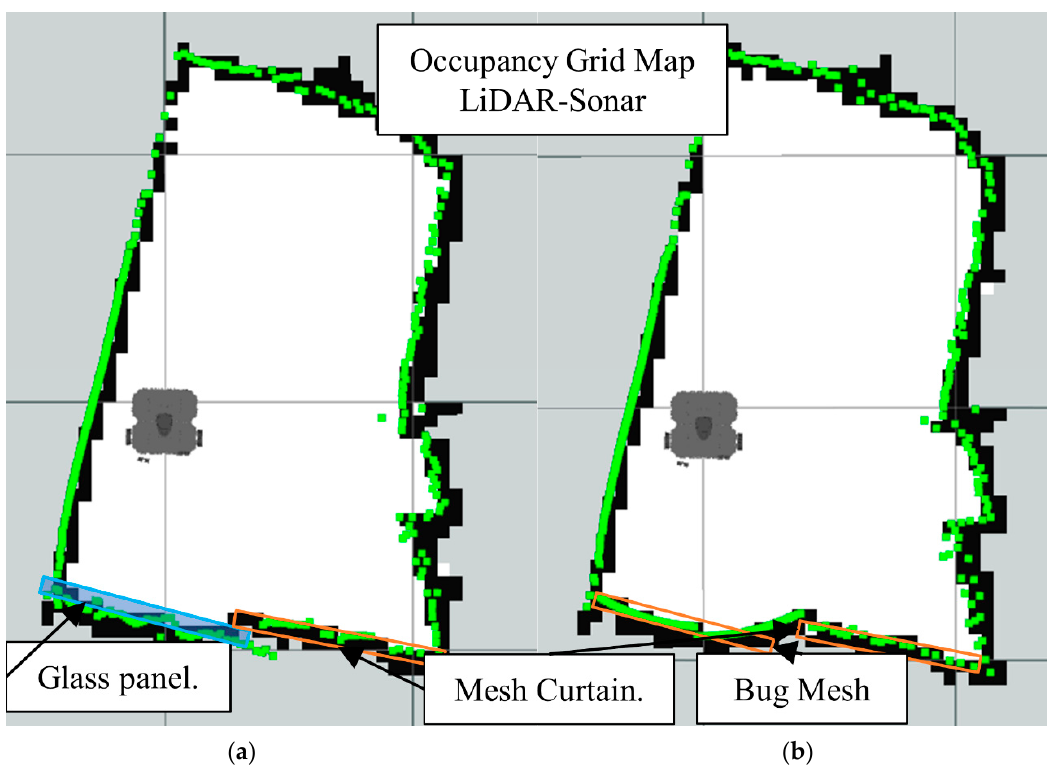
Figure 28. Occupancy grid maps showing the: ( a ) Ground truth (reference map); ( b ) LiDAR-Sonar fusion generated map with insect door mesh in front of the glass.